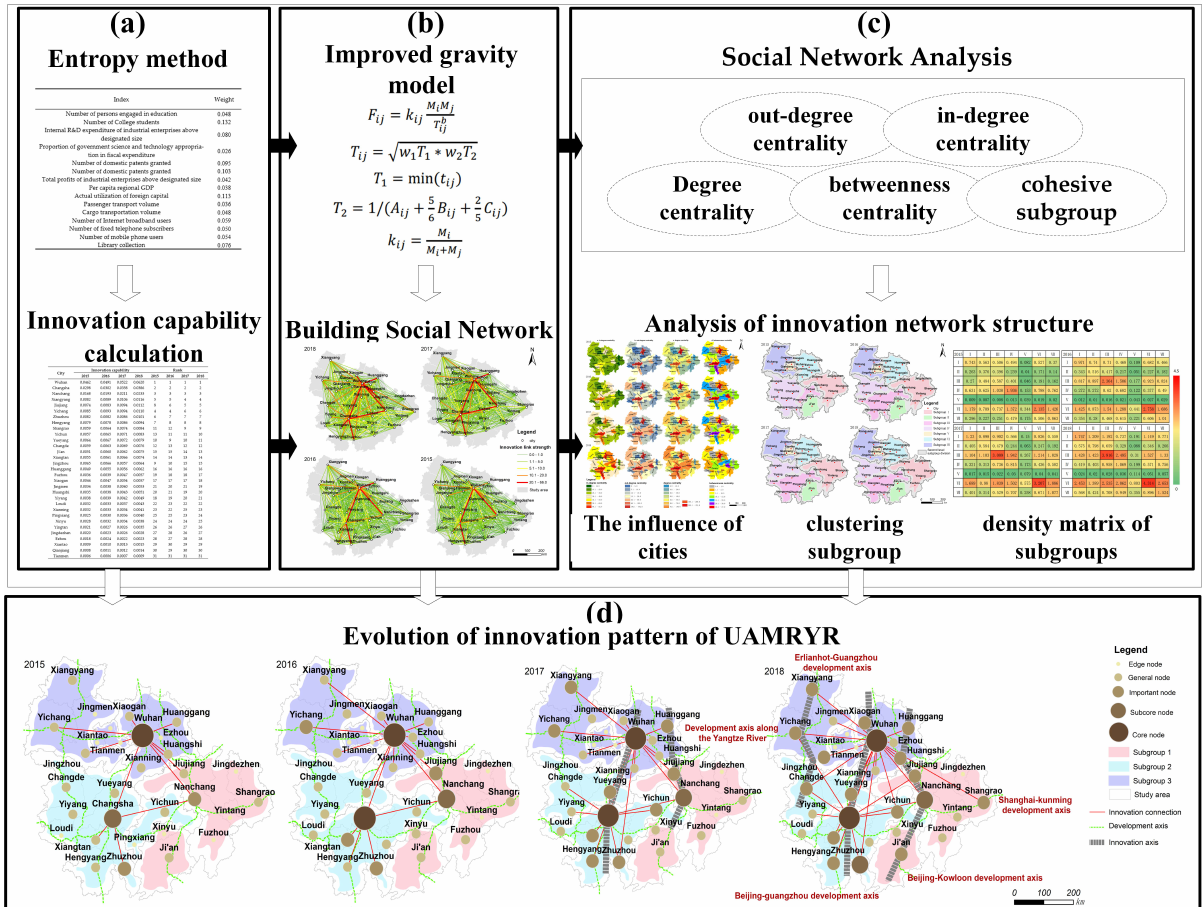
Figure 2. Research framework: ( a ) Calculating the innovation capability (results see Section 3.1). ( b ) Building the innovation network (results see Section 3.2). ( c ) Analyzing the structure of the innovation network (results see Sections 3.3 and 3.4). ( d ) Discussing the innovative pattern (results see Section 4).